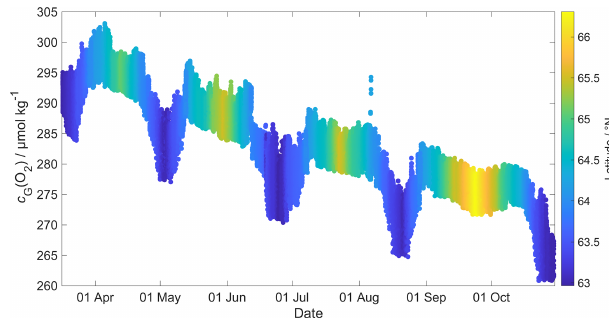
Figure 2. Glider oxygen concentration, c G (O 2 ), for σ 0 > 1028kgm − 3 coloured by latitude.